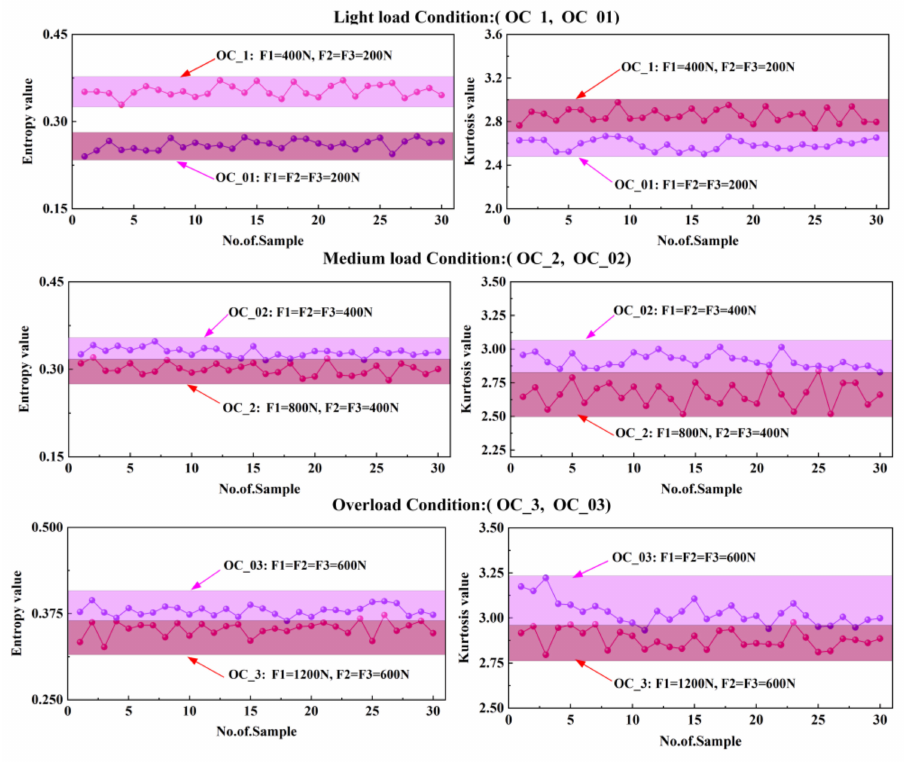
Figure 14. The characteristic distribution map of the bearing running under different load